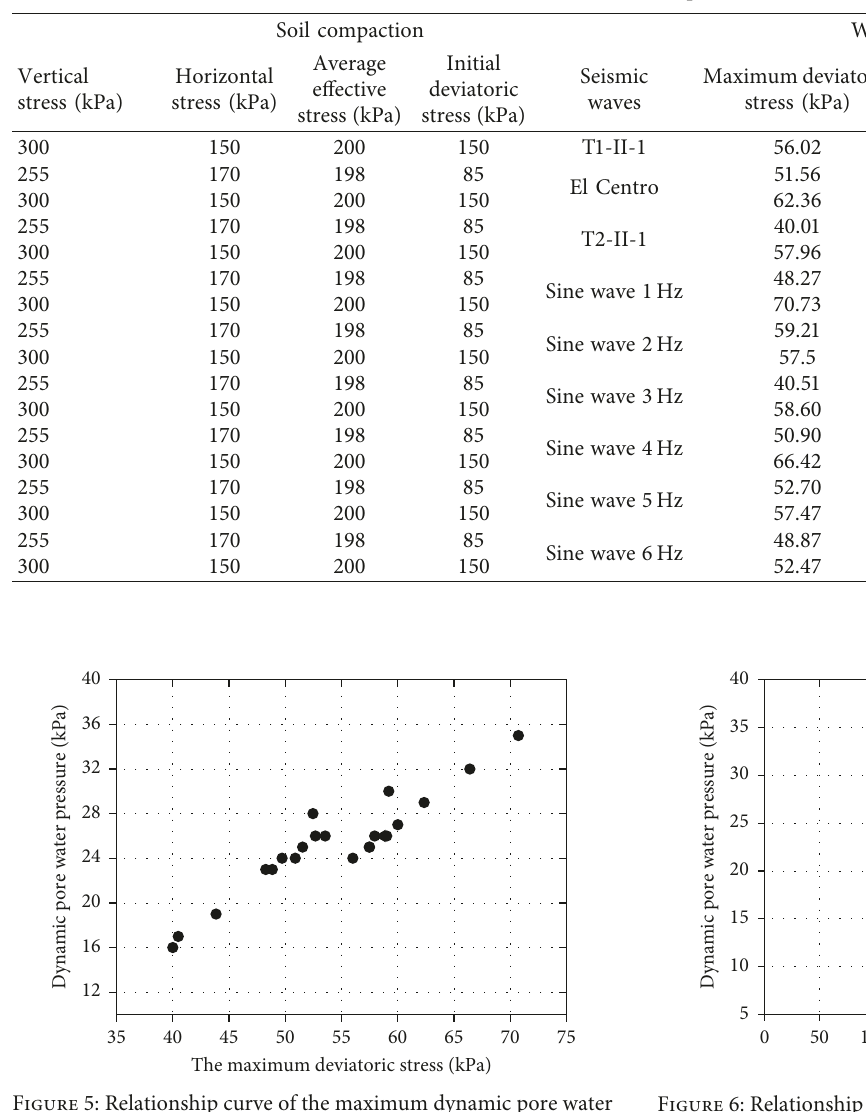
Table 5: Test results under earthquakes and sine waves.